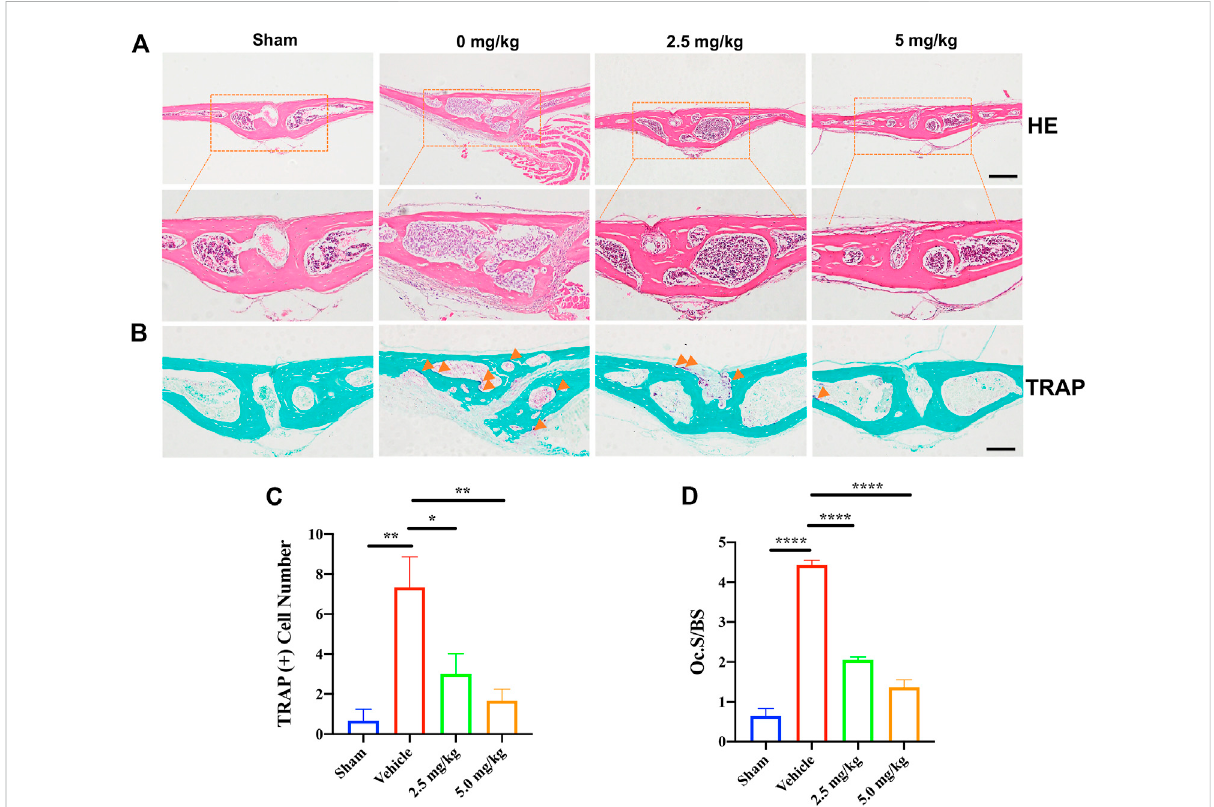
H&E and TRAP staining were performed on the calvarial tissue collected from the Sham, PBS vehicle, and CDZ173 treated groups. Representative images of calvaria stained with H&E (A) and TRAP (B) , histological assessment of (C – D) , and number of osteoclasts per fi eld of tissue (TRAP + Number) and (Oc.S/BS) in sections were shown (scale bar = 500 µM) (* p < 0.05, ** p < 0.01, **** p <